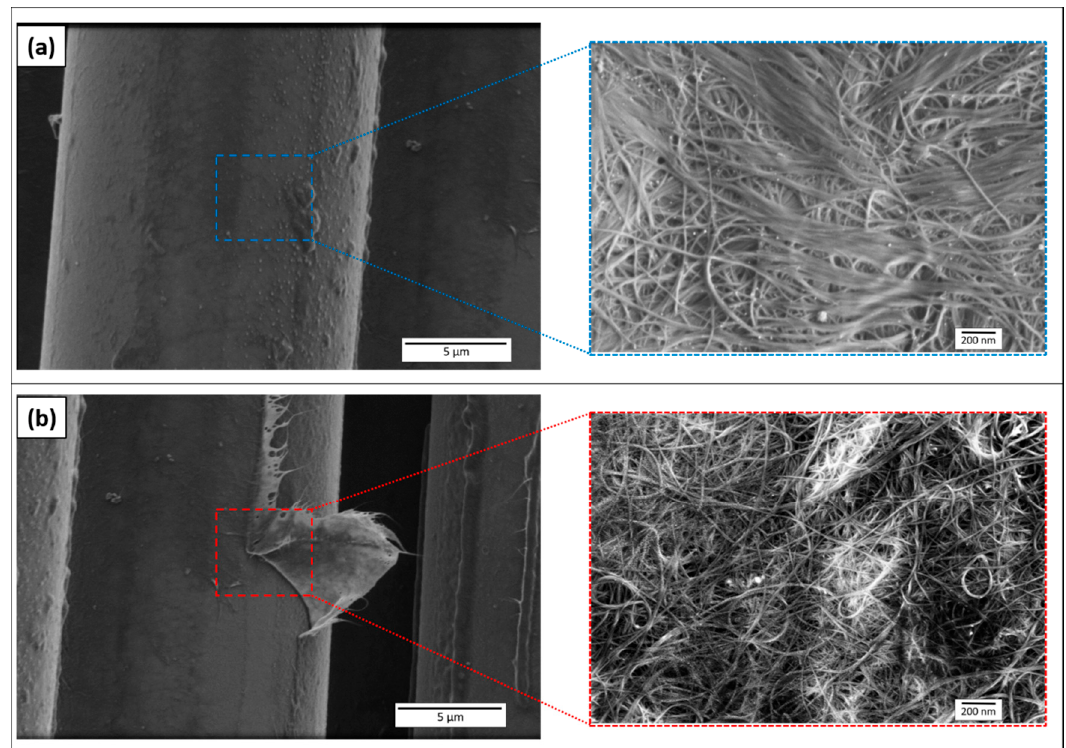
Figure 4. Scanning electron microscopy (SEM) images depicted surface morphology characteristics at